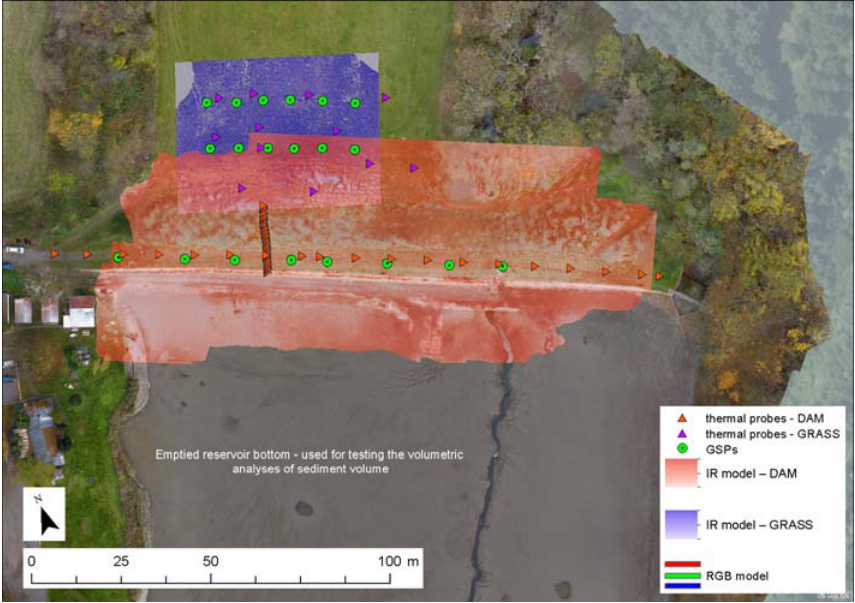
Figure 2. Podvinak dam situation and overview of the experiment setup and measuring